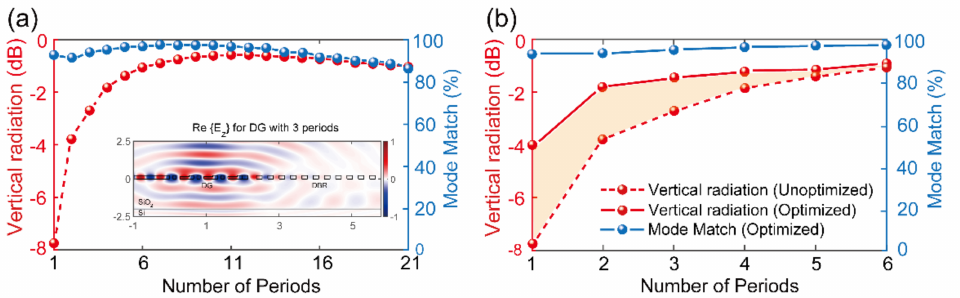
Figure 6. Performance of DGs with different numbers of periods. ( a ) The vertical radiation is deteriorated in DGs with small periods. The inset shows the real part of E z of the DG with 3 periods. Here, structural parameters except the number of periods of DG are the same as those in Figure 4. ( b ) The optimal performance of DGs (solid line) with 1 to 6 periods whose structural parameters are found by using the particle swarm algorithm to ensure low diffraction